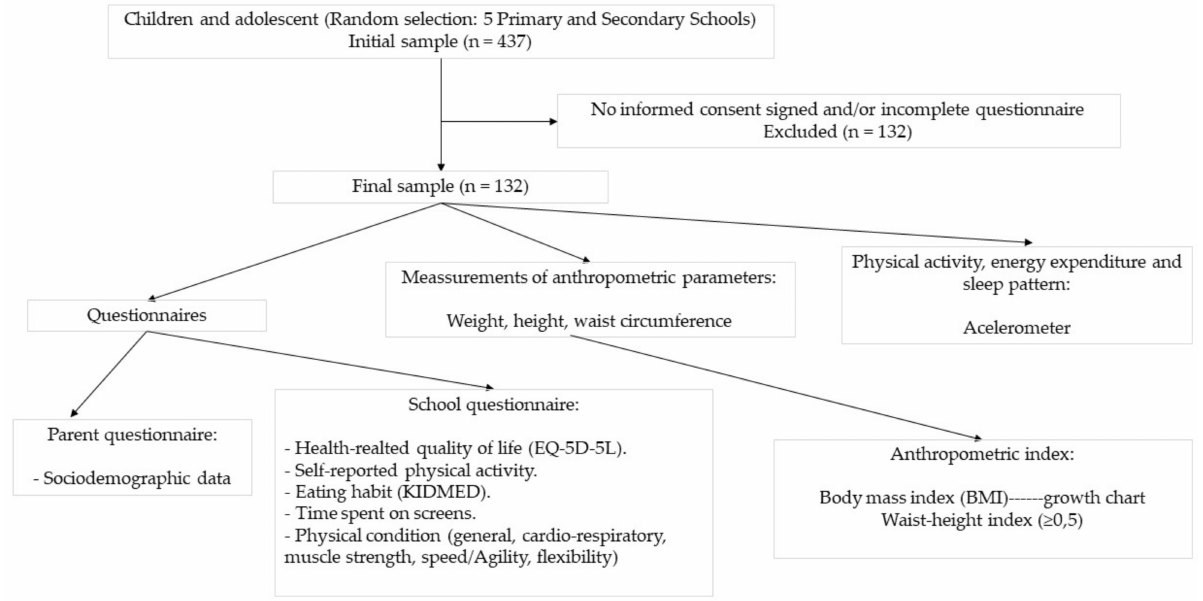
Figure 1. Flowchart of the